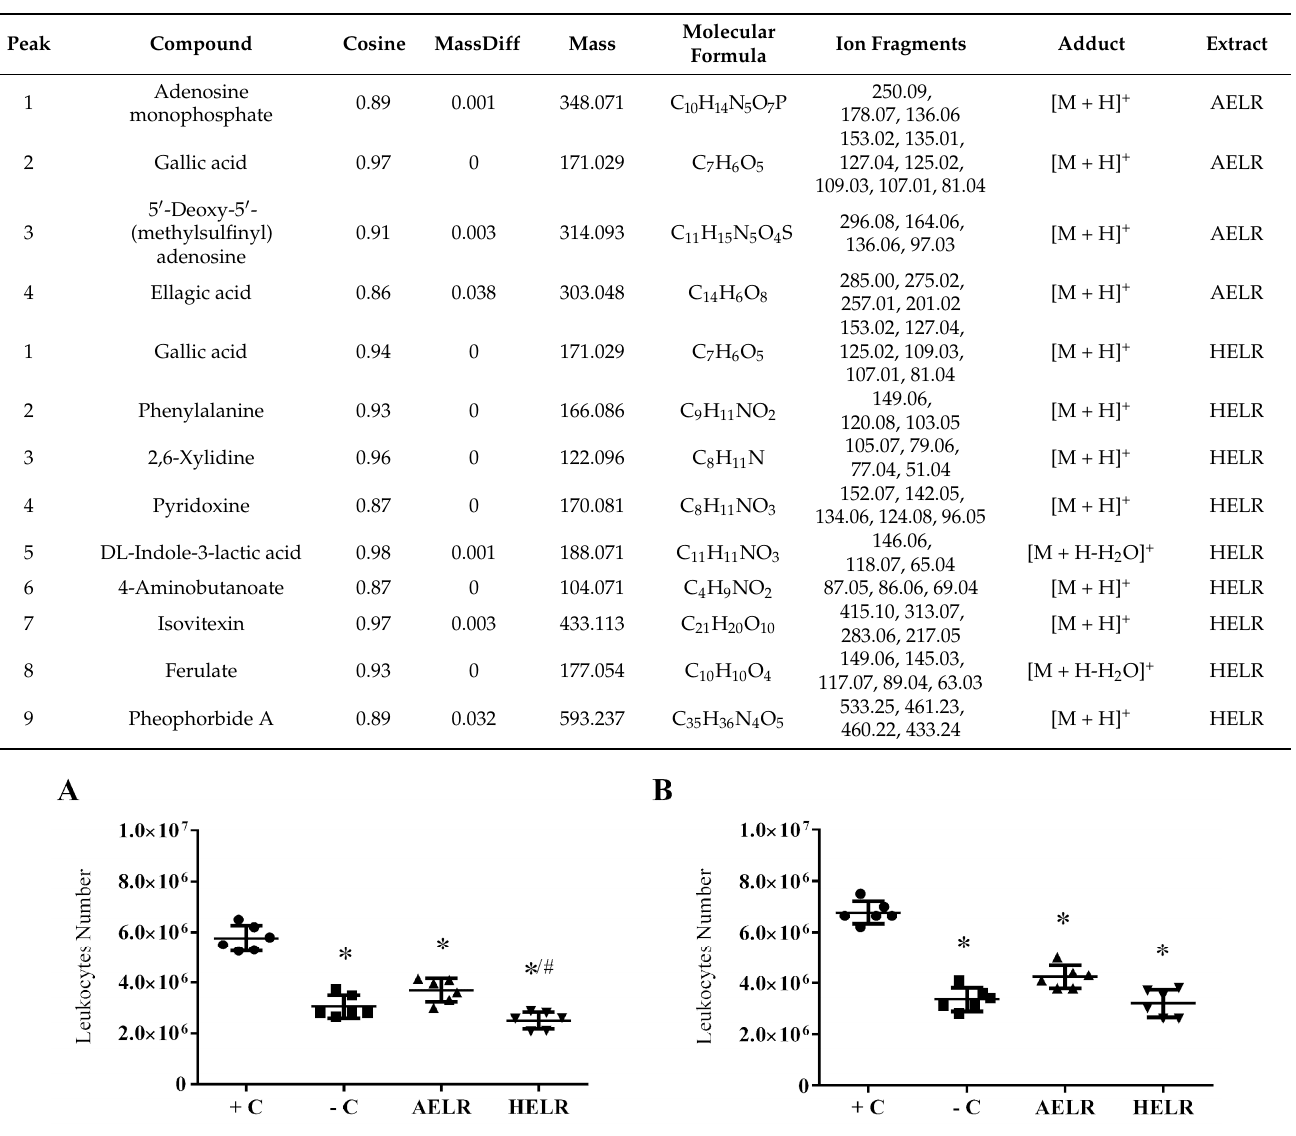
Table 1. Phytocomponents identified in L. rigida leaf extracts by LC-MS/MS analyses. L. rigida aqueous leaf extract (AELR); L. rigida hydroethanolic leaf extract (HELR).